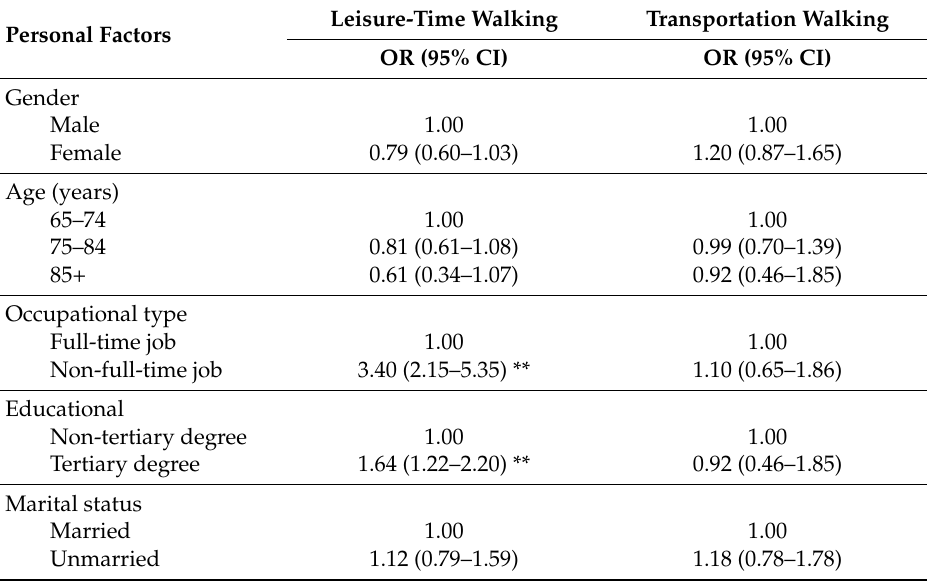
Table 2. Personal factors associated with walking for leisure and